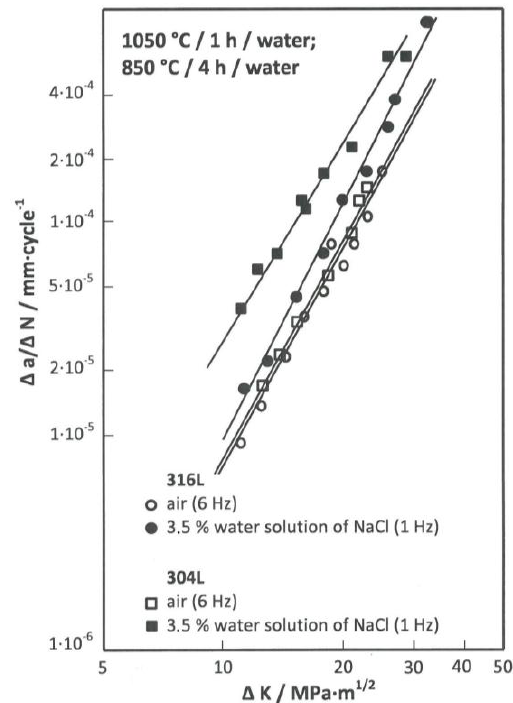
Figure 6. Kinetics of fatigue crack growth for 304L and 316L steels after stabilization annealing.